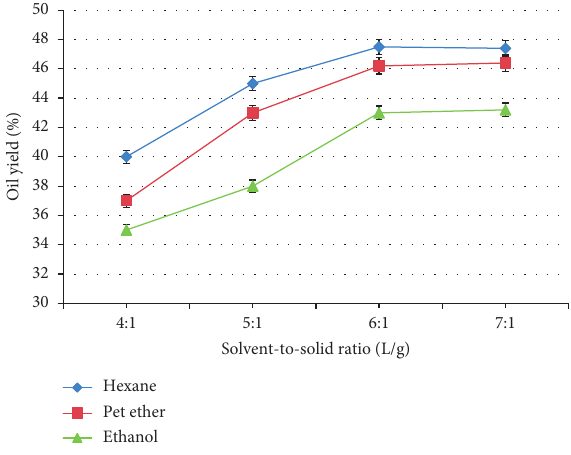
Figure 4: Effect of solvent-to-solid ratio.